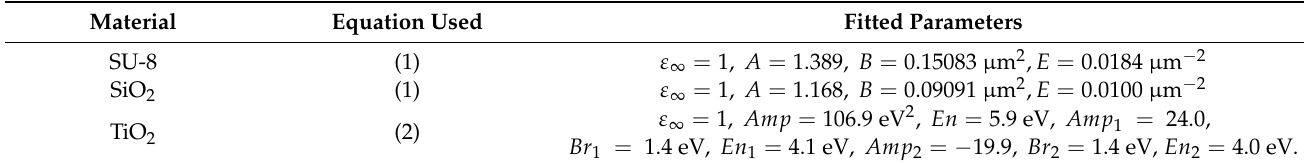
Table 2. Materials’ fitted parameters. Table 2. Materials ’ fitted parameters.